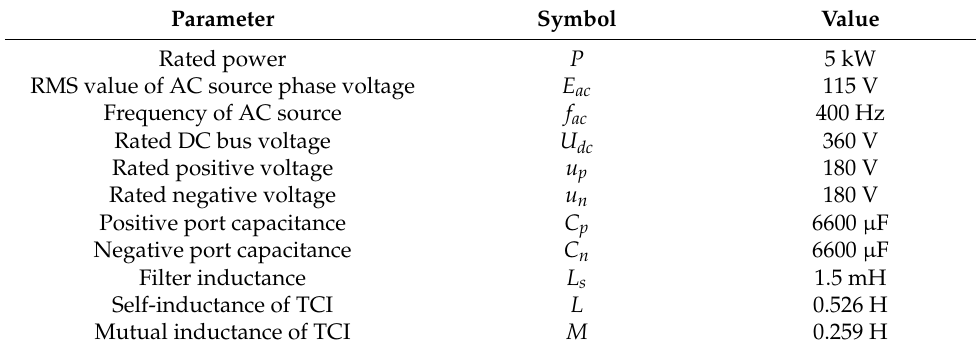
Figure 9. Experimental platform of the TCIBAR. Table 5. Parameters of the experimental platform. Table 5. Parameters of the experimental